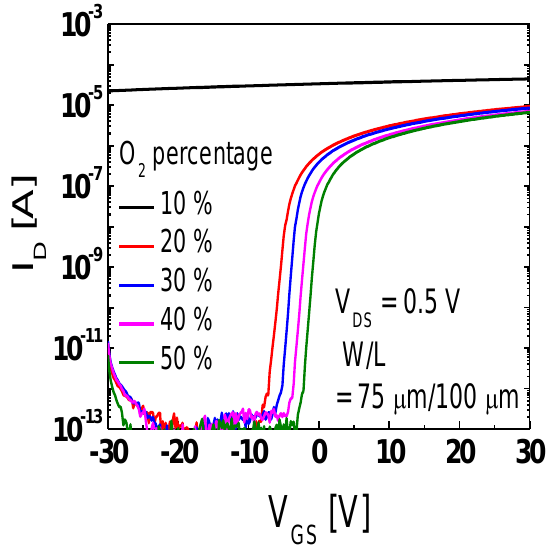
Figure 2. Semi-logarithmic scale plot of the transfer curves measured from the IGTO TFTs (W/L = 75 μm/100 μm) prepared at oxygen contents of 10%, 20%, 30%, 40%, and 50% in the sputtering am- bient.